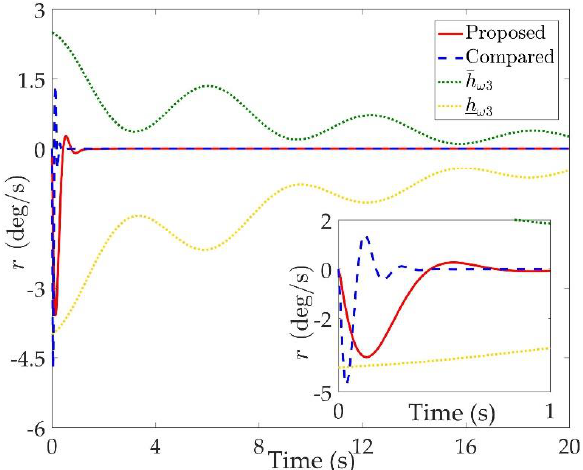
Sensors 2020 , 20 , 848 Figure 7. Comparison curves of the yaw rate <!-- MathType@Translator@5@5@MathML2 (no Figure 7. Comparison curves of the yaw rate r .